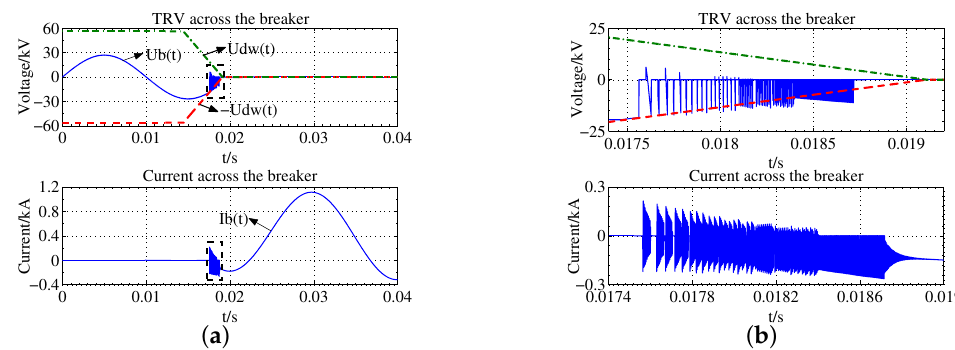
Figure 3. Modeling of VCB in PSCAD/EMTDC: ( a ) prestrikes simulation result of VCB; and ( b ) zoomed-in view.